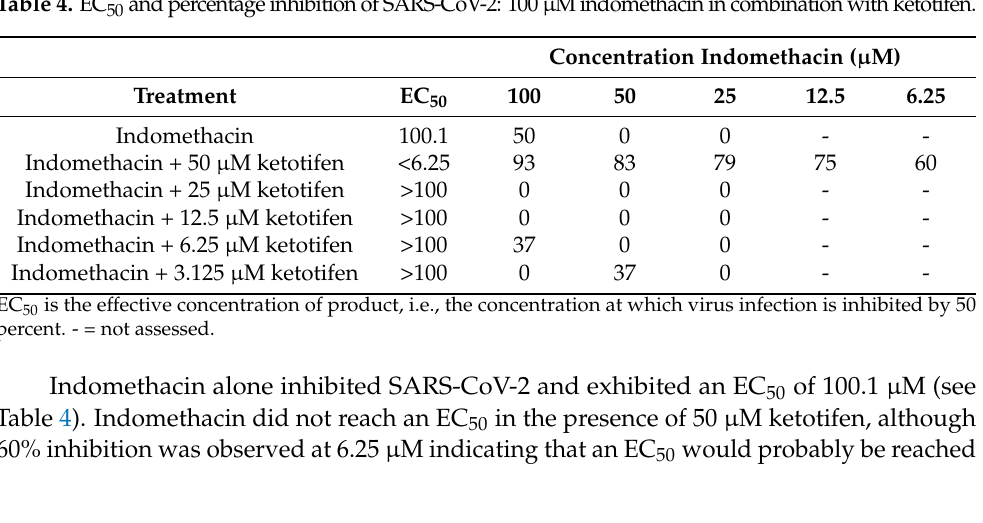
Table 4. EC 50 and percentage inhibition of SARS-CoV-2: 100 μ M indomethacin in combination with ketotifen.